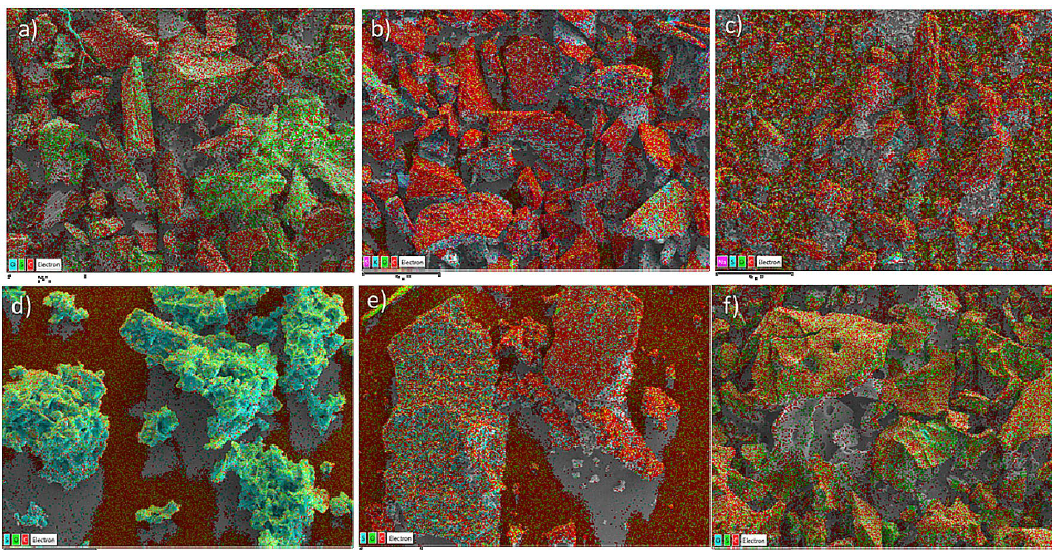
Figure 4. EDX mapping of the PACs based on activation solutions where ( a ) is RSS H 2 SO 4 , ( b ) is RSS KOH, ( c ) is RSS NaOH, ( d ) is RS H 2 SO 4 , ( e ) is RS KOH, and ( f ) is RS NaOH.